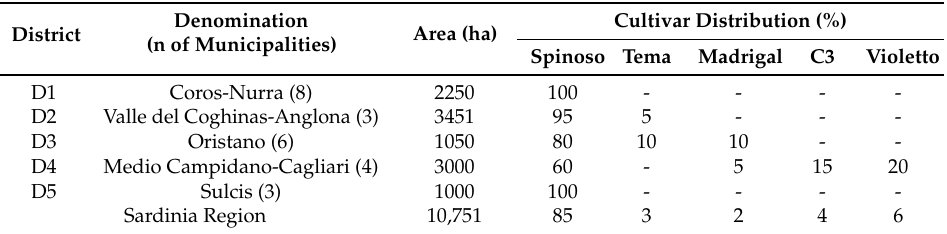
Table 1. Sardinian artichoke districts, year 2015. Authors’ elaboration on data from [36,50–52]. Denomination Cultivar Distribution (%) Area (ha) District (n of Municipalities) Spinoso Tema Madrigal Coros-Nurra (8) Valle del Coghinas-Anglona (3)